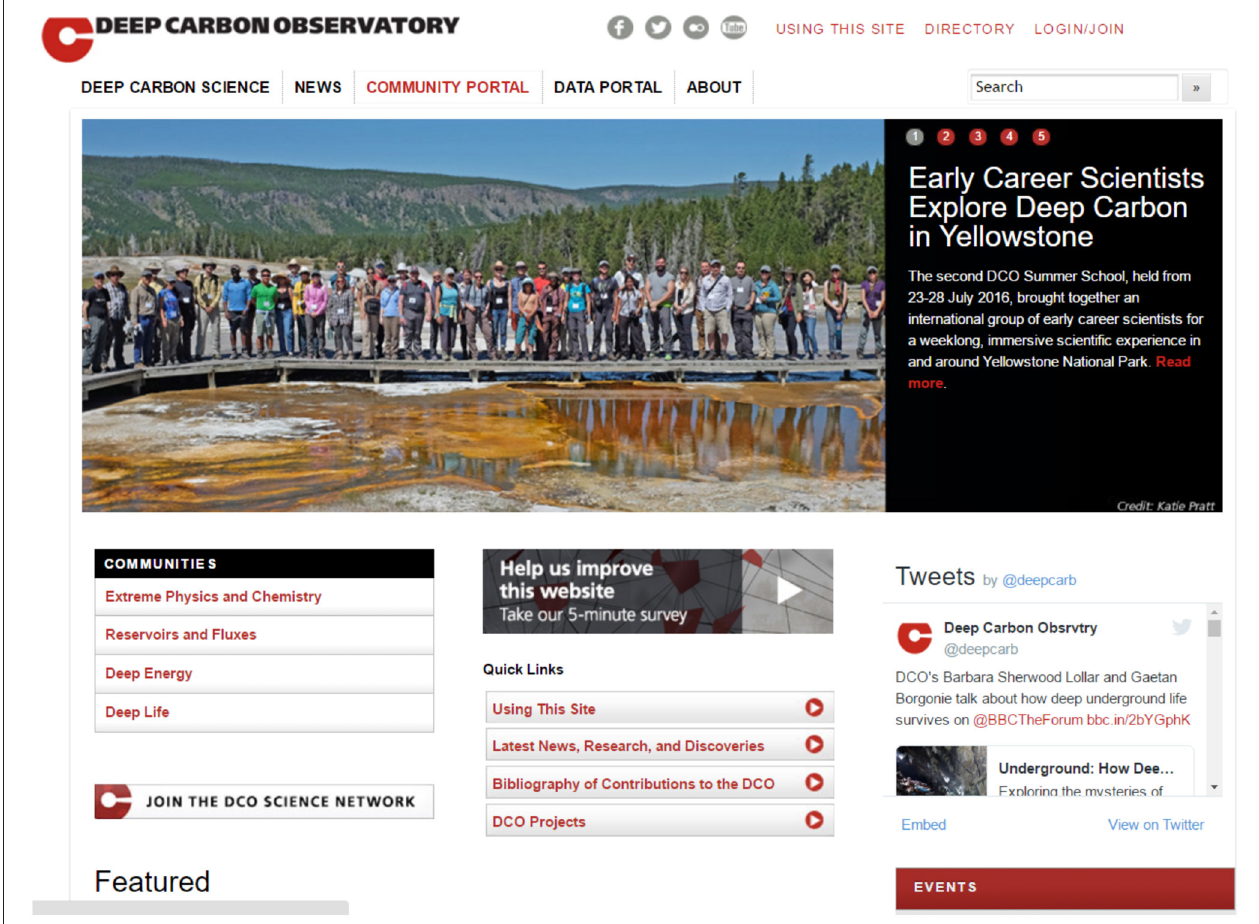
FIGURE 3 | A screenshot of the DCO community website